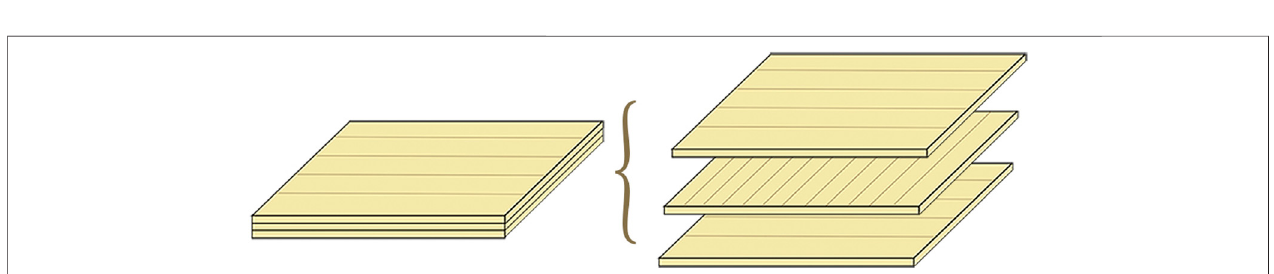
FIGURE 2 | Schematic diagram of 3-layer transparent wood